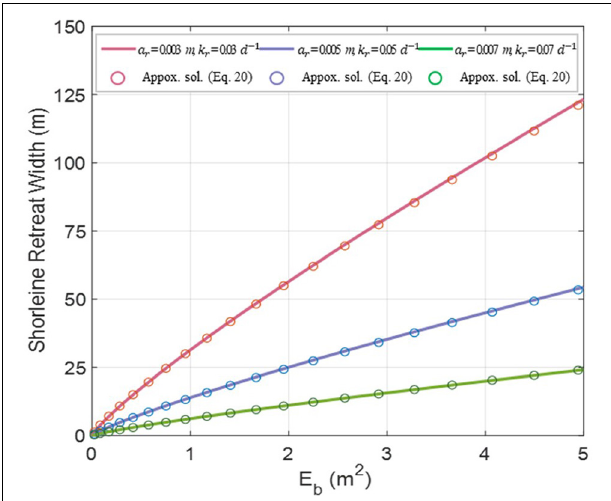
FIGURE 15 | Comparison between model results (Eq. 7) and approximate solutions (Eq. 20) for 3 different points of a r and k r .